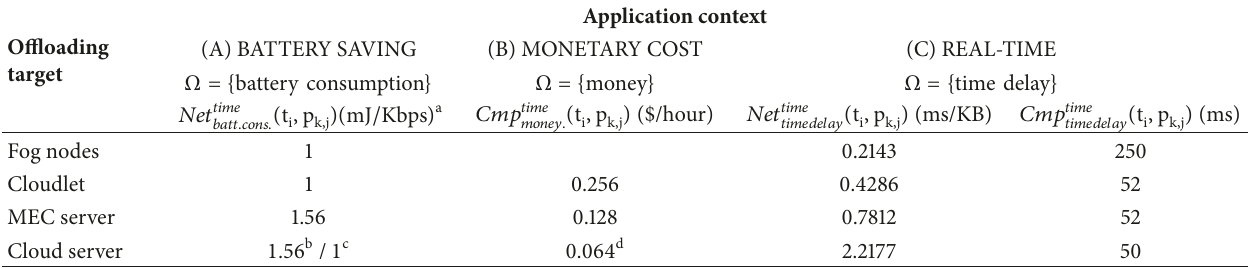
Table 5: Performance